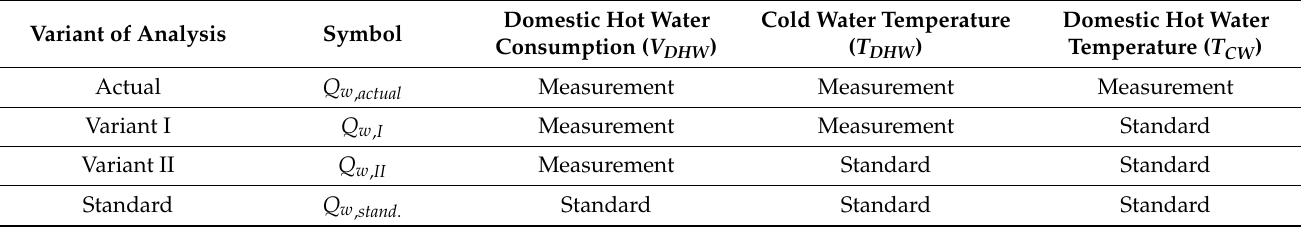
Table 5. Variants for use of dwellings (domestic hot